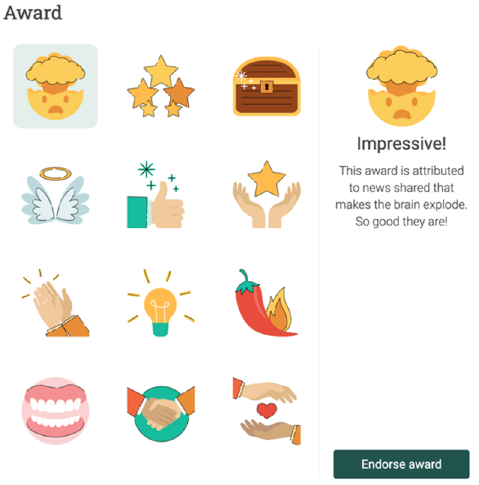
Figure 4. Endorsing awards modal (Authors’ copyright).